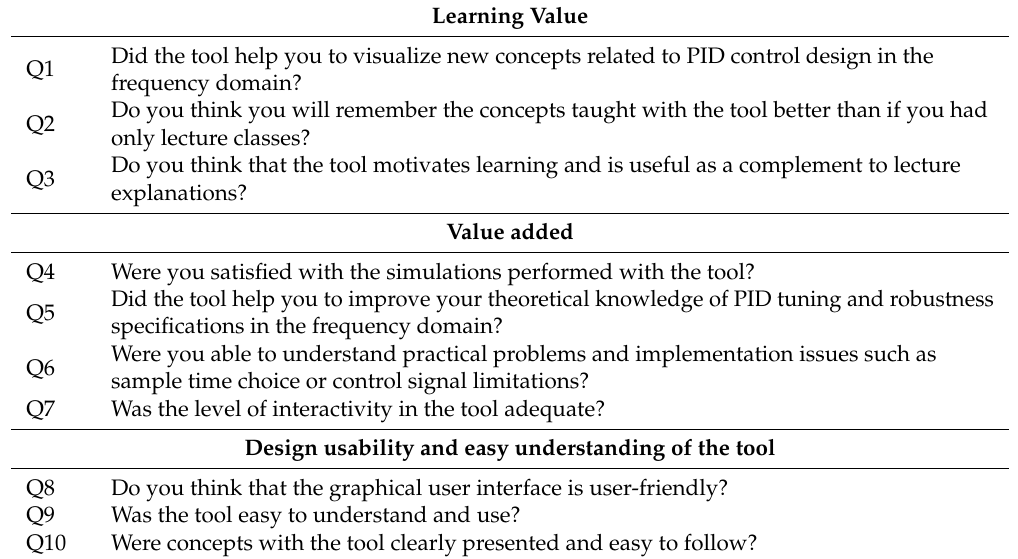
Table 8. Students’ responses to the tool survey (number of students = 45).